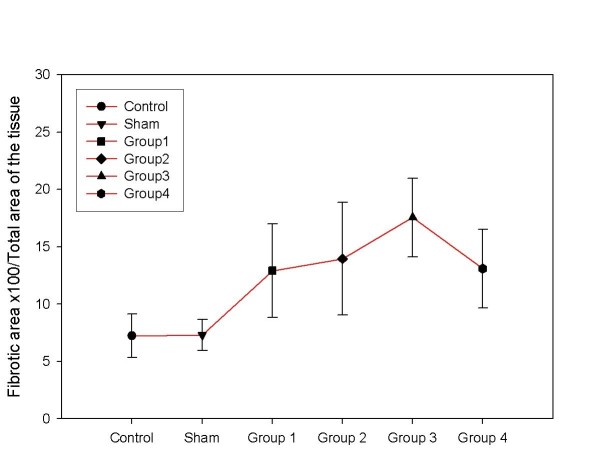
There was a significant increase in hepatic collagen amount in BDL groups histomorphometricaly compared to the control and sham groups (P < 0.01). Collagen peak was found at the end of the third week when compared to the groups 1, 2 and 4 (P < 0.05).